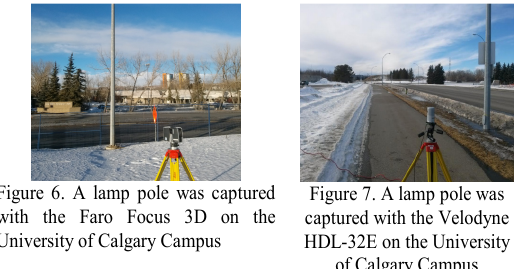
Figure 6. A lamp pole was captured with the Faro Focus 3D on the University of Calgary Campus